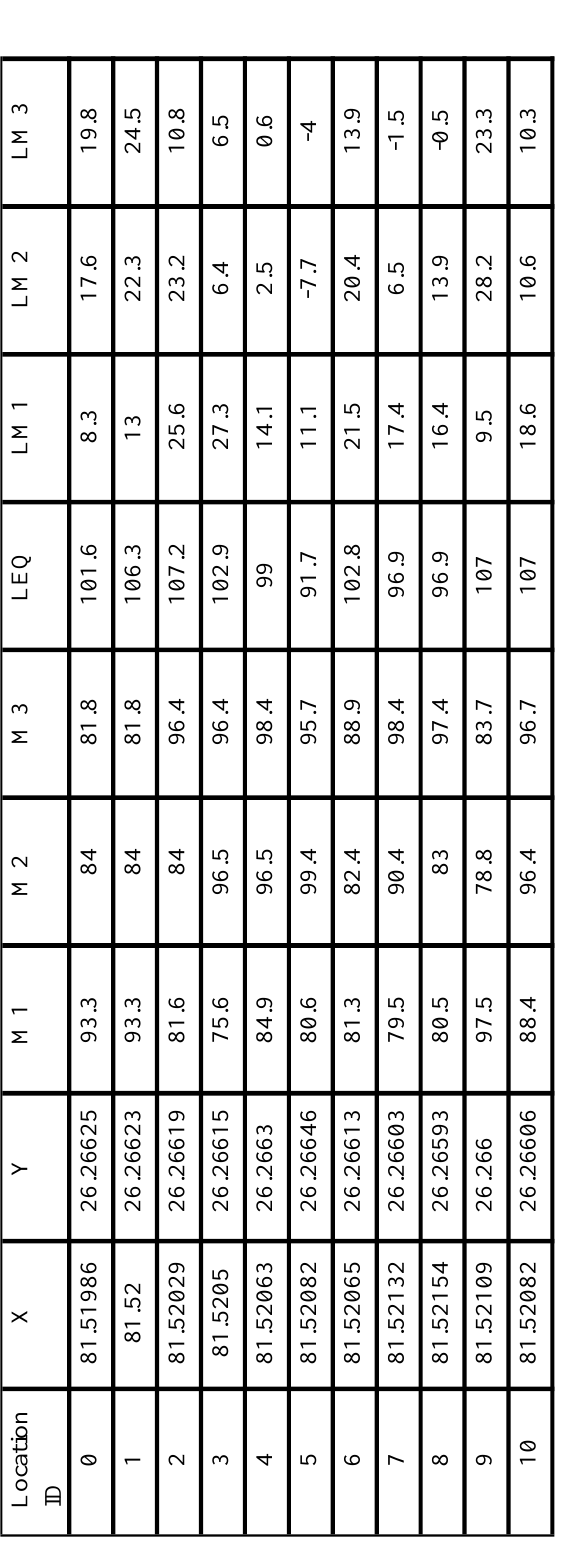
Figure 6. Average Model Noise Map at Bahadurpur Road Average Model Noise prediction where some parameters used such as Distance attenuation and Building attenuation and where we find the 5-10 dB difference between predicted and the observed value